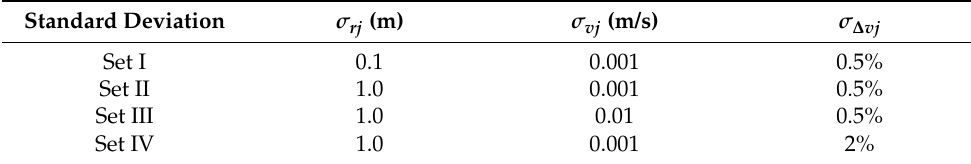
Table 5. Standard deviations of different combinations.